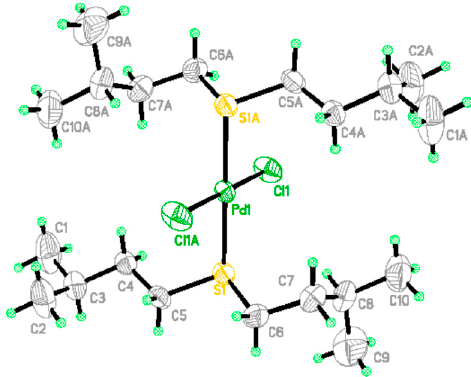
Figure 11. The X-ray crystal structure of PdCl 2 (S 201 ) 2 complex. Table 6. Crystallographic data and refinement parameters for PdCl 2 (S 201 ) 2 .